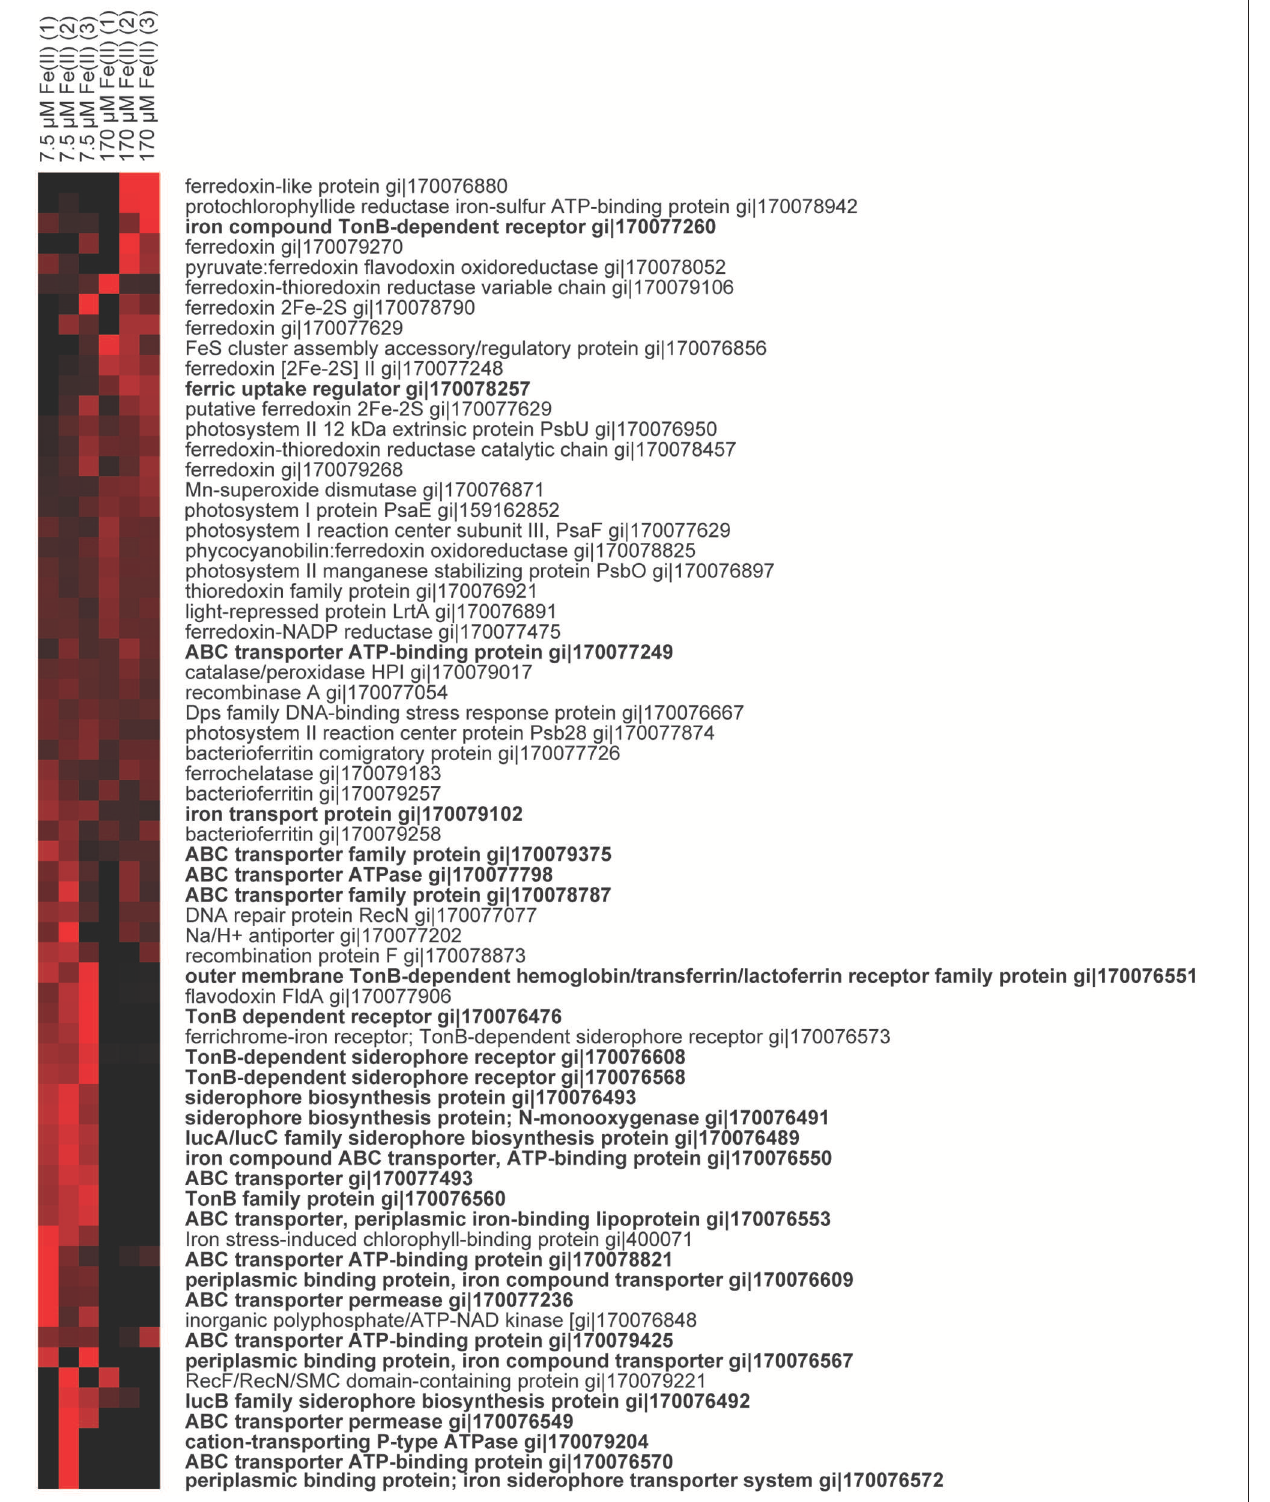
Frontiers in Earth Science | www.frontiersin.org